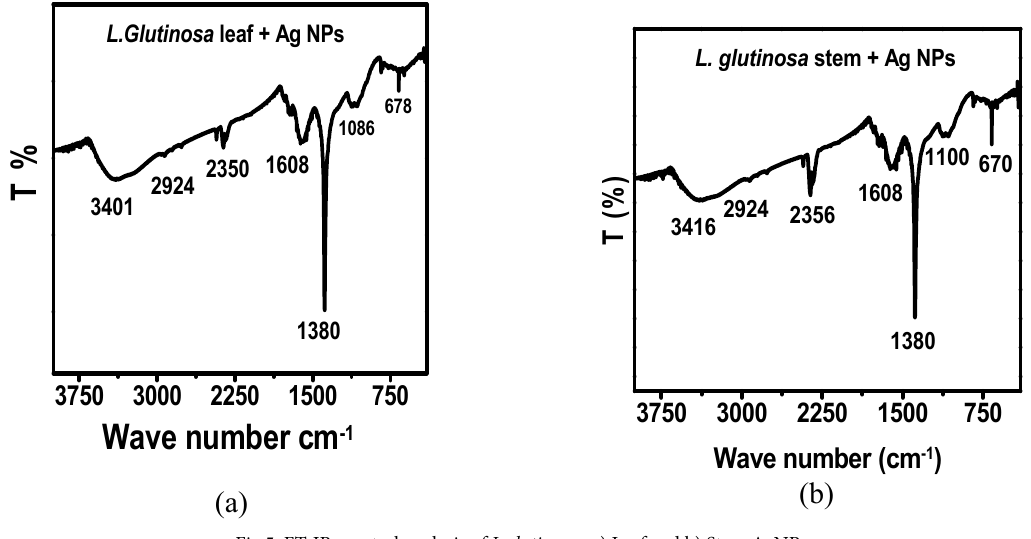
Fig.5. FT-IR spectral analysis of L.glutinosa. a) Leaf and b) Stem